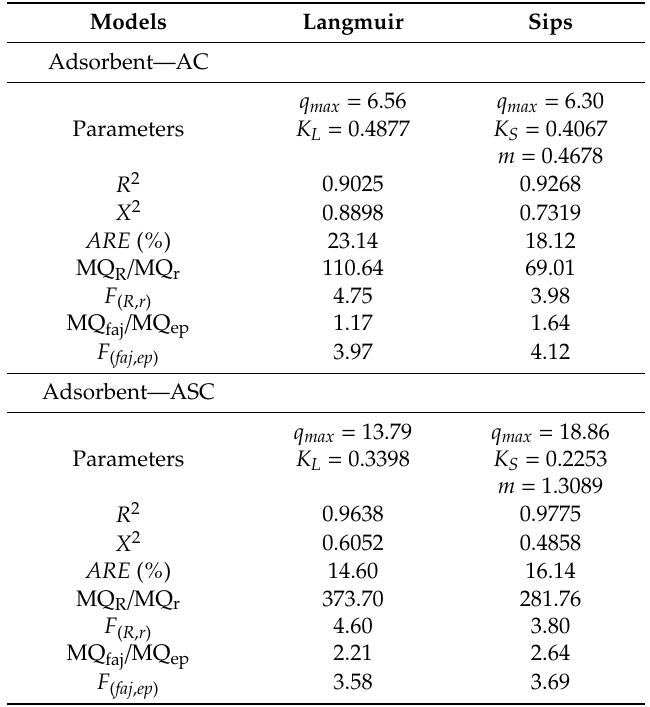
Table 3. Isotherm parameters for MB adsorption onto AC and ASC at 25 ◦